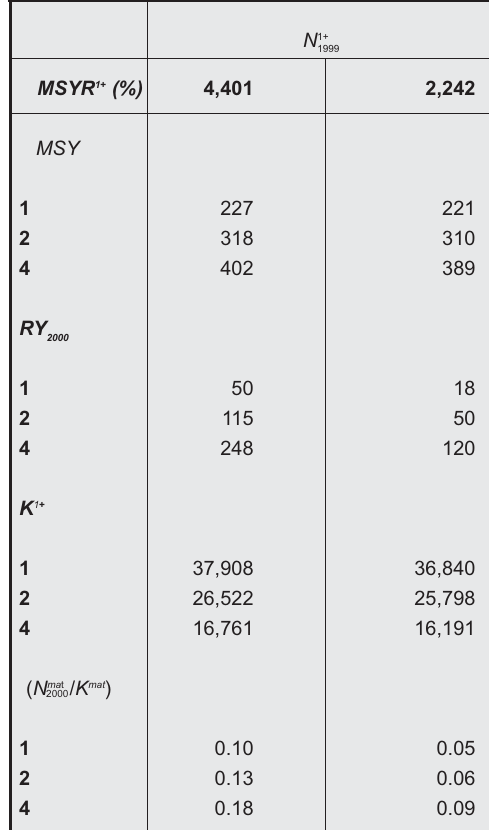
Table 1b. Parameters of population trajectori- es which hit the best estimate (4,401) and cor- responding lower 5%-ile (2,242) total (1+) po- pulation sizes in 1999 for various values of MSYR 1+ for the “Upper” stock for the two stock scenario for beluga whales off West , Greenland. Results are shown for MSY, RY 2000 the pristine (pre-exploitation) total population size ( K 1+ ), and the current status of the mature component of the population relative to pristi- ne ( N ma t / K mat